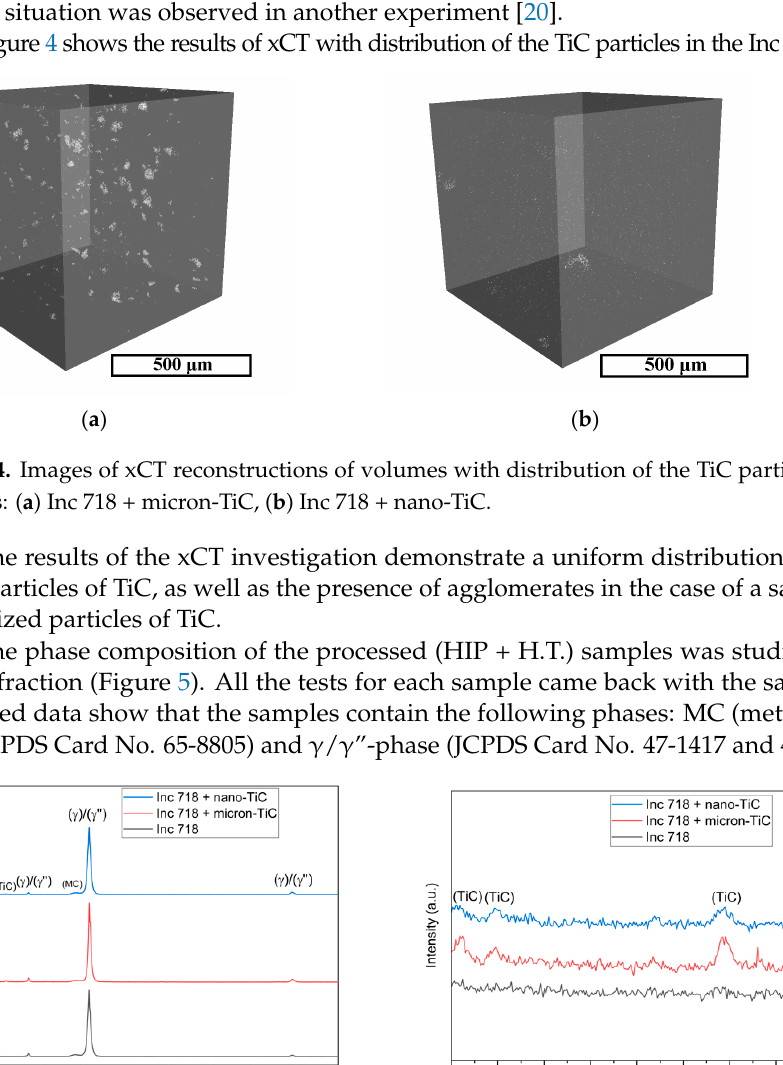
Figure 3. Optical microscope images of the TiC particles in SLM samples: ( a ) Inc 718 + micron-TiC, ( b ) Inc 718 + micron-TiC after HIP + H.T., ( c ) Inc 718 + nano-TiC, ( d ) Inc 718 + nano-TiC after HIP + H.T.